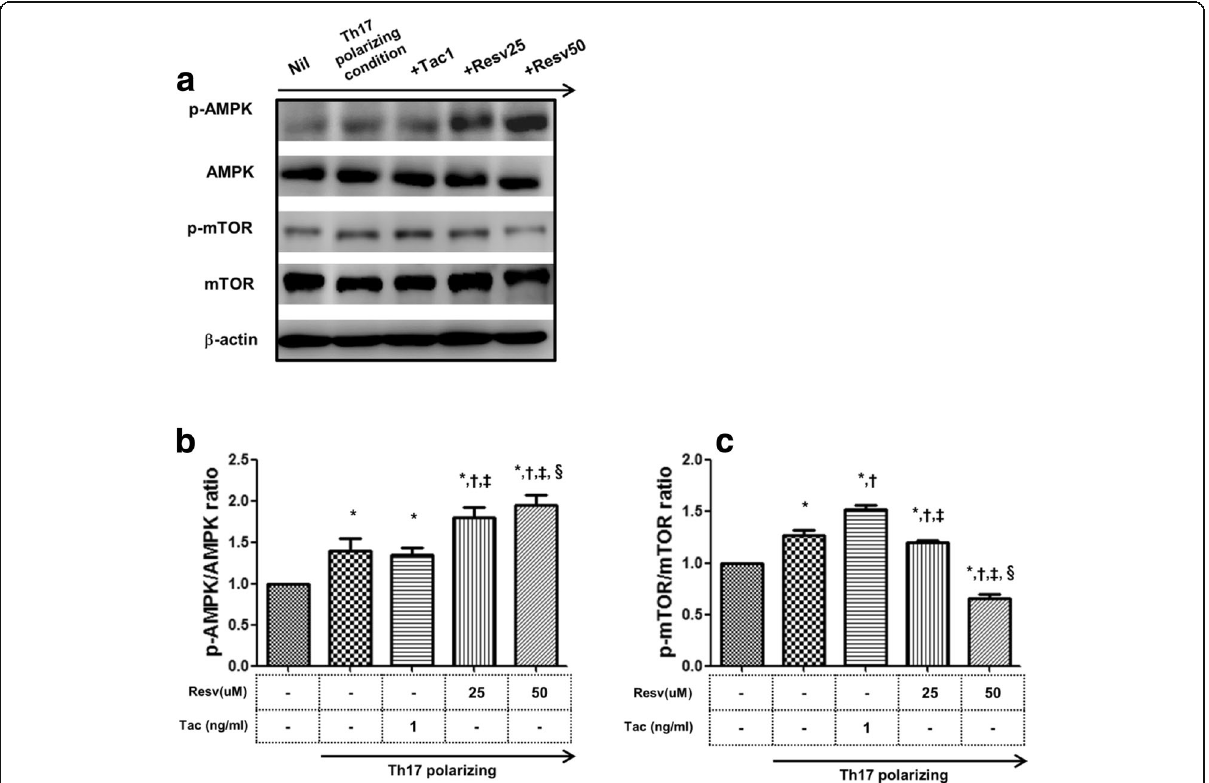
Fig. 5 Effects of Tac or Rasv on the expression of mTOR and AMPK proteins in the Jurkat cell line. ( a ) Immunoblotting of p-Ampk, Ampk, p- mTOR,, and mTOR in the Jurkat cell line pretreated with Tac (1 ng/mL) or Resv (25, 50 nM) and then cultured under Th17-differentiation conditions. Stimulation of Jurkat cells under Th17-differentiation conditions activated phosphorylation of ( b ) AMPK, and ( c ) mTOR as detected by Western blotting and shown by the ratio of phosphorylated proteins to total proteins. Tac did not change p-AMPK or p-mTOR. In contrast, treatment with Resv resulted in the reduction of p-mTOR and an increase in p-AMPK. *P < 0.05 vs. Nil and † P < 0.05 vs. Th17 polarizing condition and ‡ P < 0.05 vs. Tac 1 ng/mL. Resv, Resveratrol; Tac,